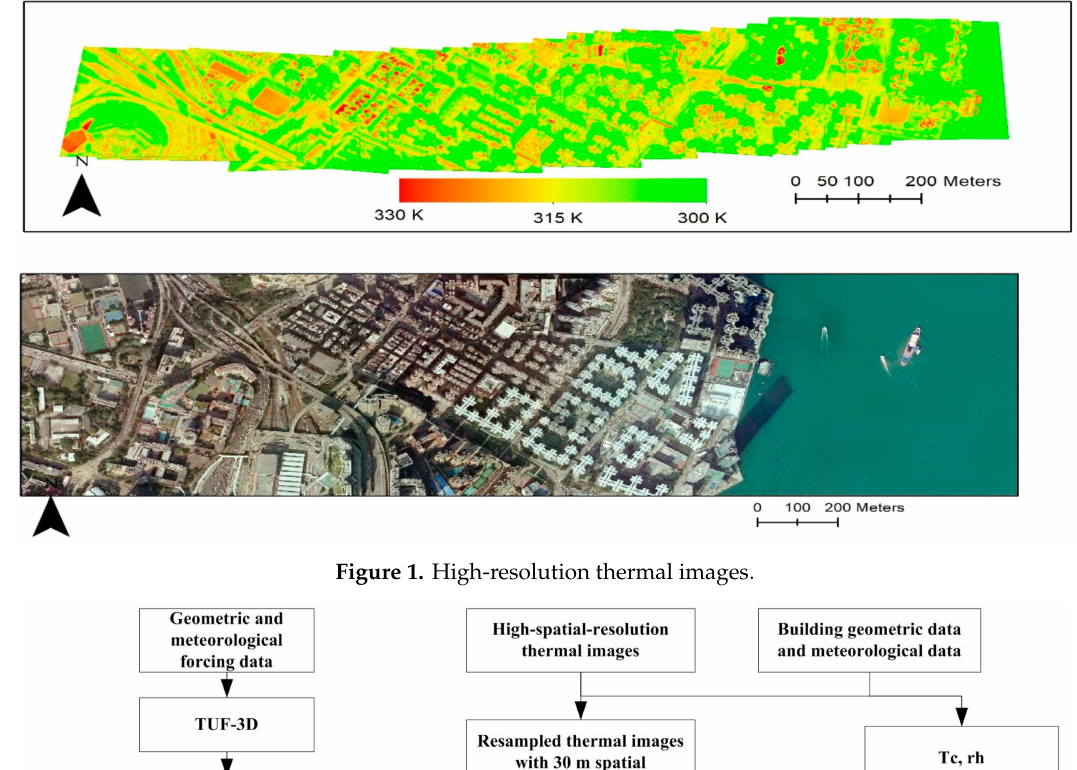
Figure 1. High-resolution thermal images.